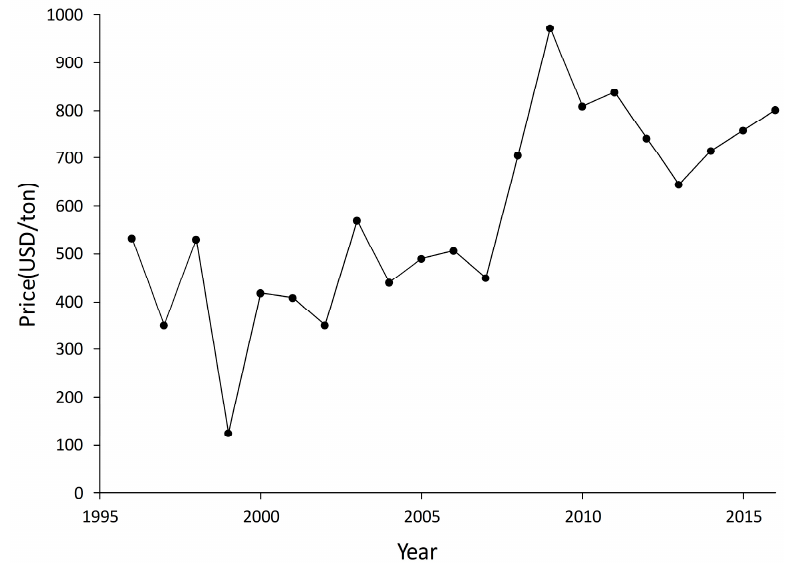
Figure 9. Producer price of pigeonpea in Malawi, Figure 8. Producer price of pigeonpea in Malawi, 1996–2016.